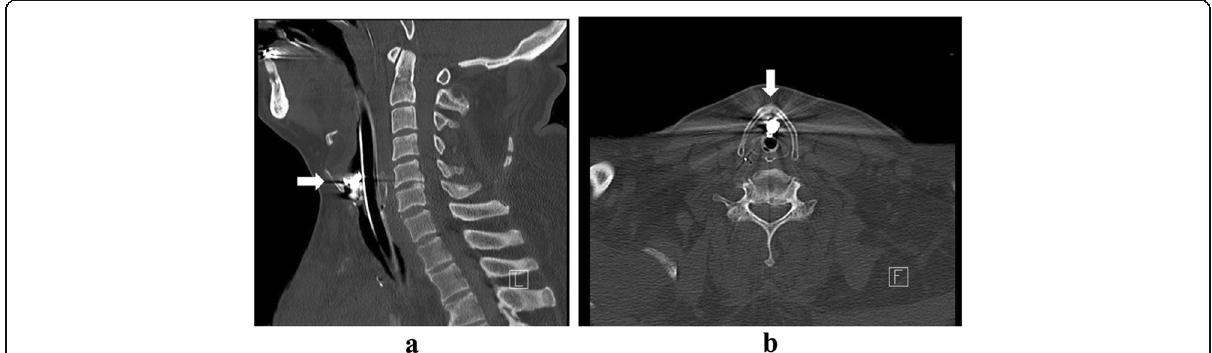
Fig. 2 Simple CT scans on POD 34. a Sagittal section. An airway foreign body (arrow) was found on the ventral side of the tracheal tube at the level of the 5th and 6th cervical vertebrae. b Horizontal section. An airway foreign body (arrow) with metal artifacts was observed. CT, computed tomography; POD, postoperative day